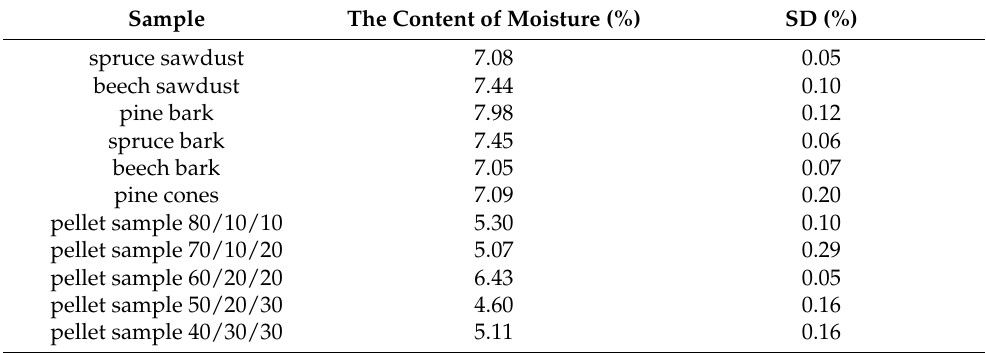
Table 4. The moisture content of investigated various uncompressed materials and produced pellets.